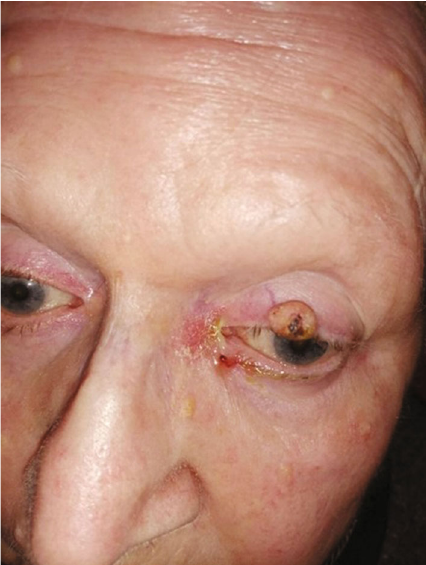
Figure 10: Patient (AF, 80 years) with dacryocystitis, basalioma, and blepharitis before Parvulan injection.